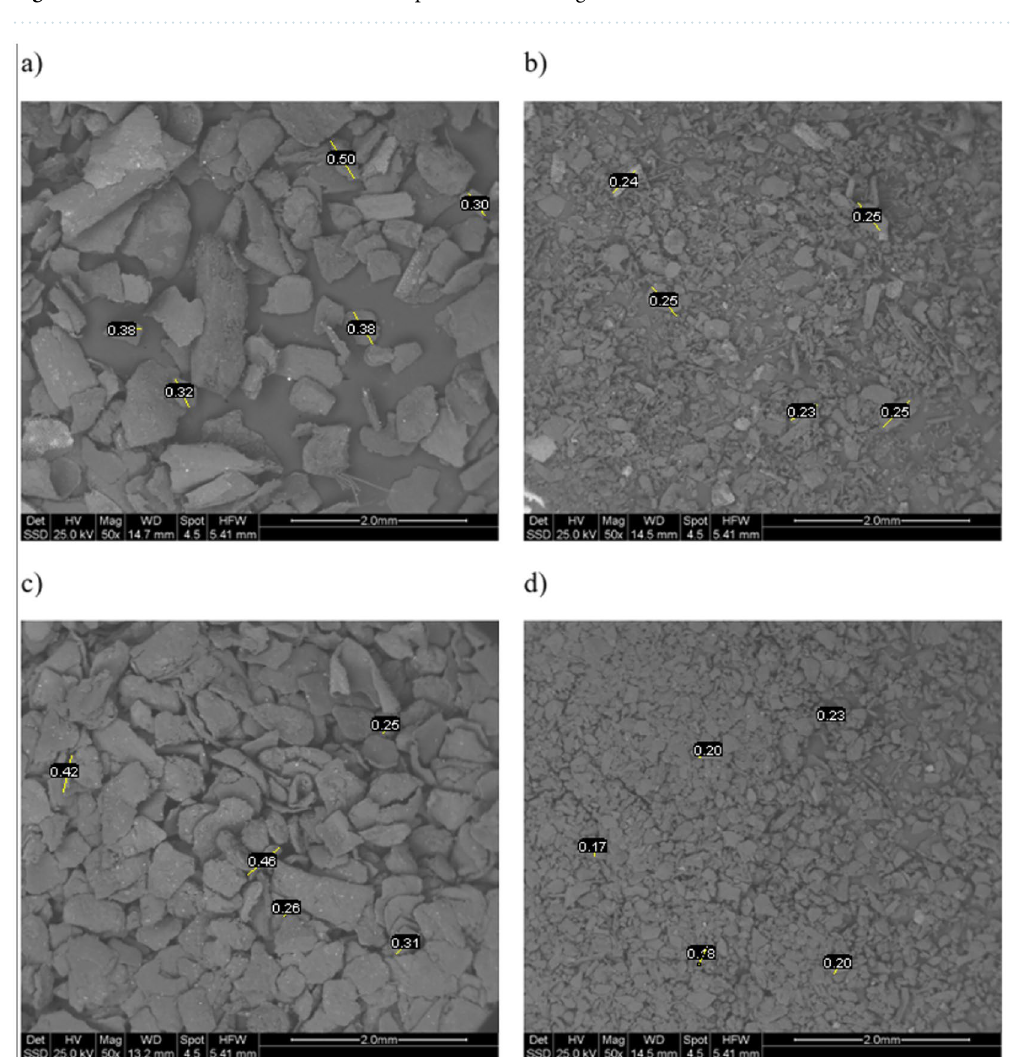
Figure 3. ESEM micrograph of the backscattered electrons at 50X all the measure are expressed in mm: ( a ) S1 > 250, ( b ) S1 < 250, ( c ) S2 > 250, ( d ) S2 <